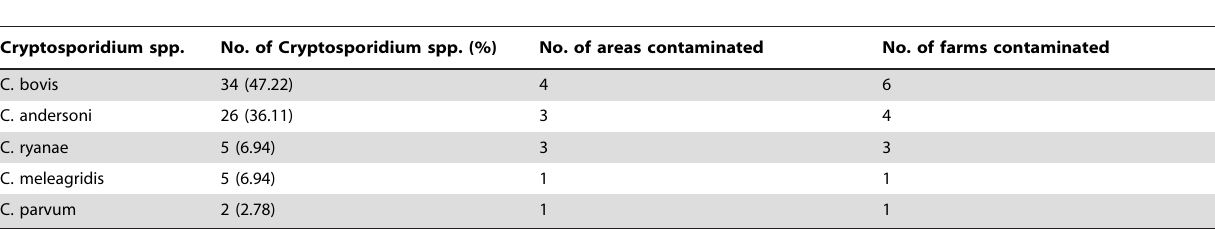
Table 2. Prevalence and percentage of different Cryptosporidium spp. on farms in Heilongjiang Province, China.